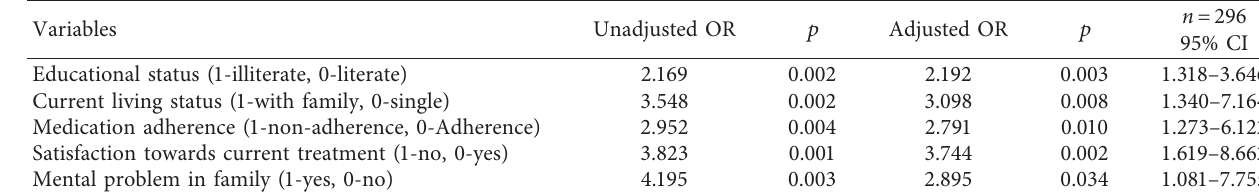
Table 6: Factors associated with the anxiety of patients.